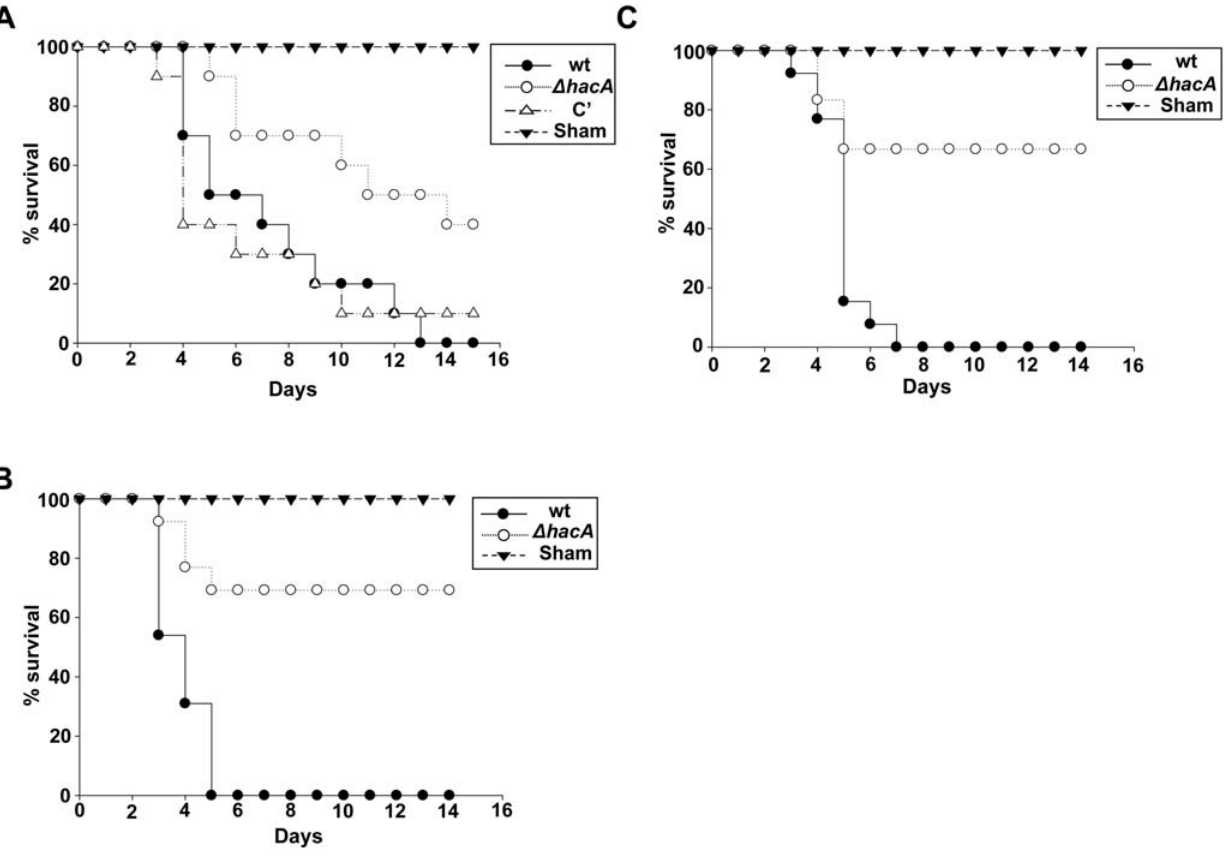
Figure 10. The D hacA mutant has attenuated virulence in three models of invasive aspergillosis. (A) Triamcinolone immunosuppression model: CF-1 outbred mice were immunosuppressed with triamcinolone acetonide and infected intranasally with conidia from the indicated strains. Mortality was monitored for 15 days. (B) Cortisone acetate immunosuppression model: C57BL/6 mice were immunosuppressed with cortisone acetate and infected intratracheally with conidia from the wt or the D hacA mutant. Mortality was monitored for 14 days. (C) Neutropenia model: C57BL/6 mice were immunosuppressed using a combination of the antibody RB6-8C5 and cyclophosphamide. The mice were infected intratracheally with the wt or the D hacA mutant, and mortality was monitored for 14 days.